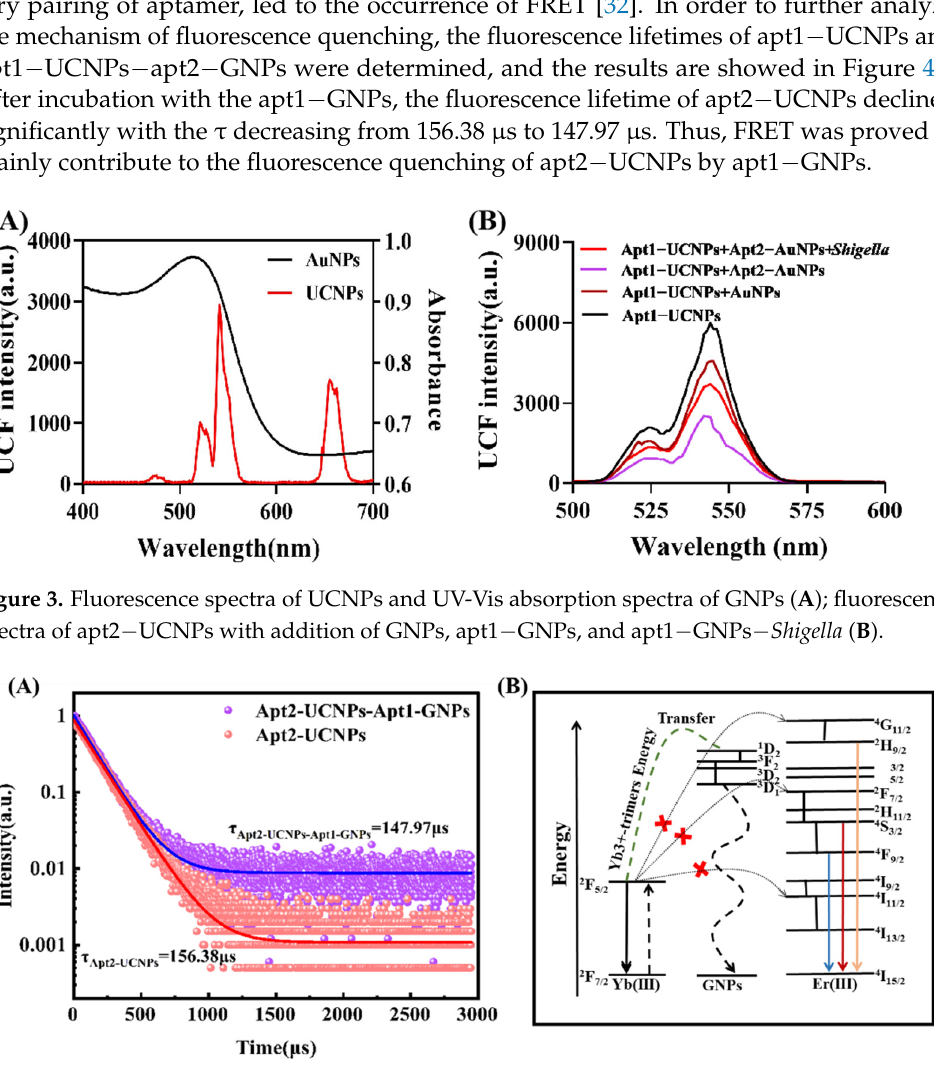
Figure 4. Fluorescence lifetimes spectra of apt2 − UCNPs and apt1 − GNPs − apt2 − UCNPs ( A ); plausi- ble energy transfer mechanism from Na(Y0 .57 Yb 0.39 Er 0.04 ) YF 4 to GNPs ( B ).